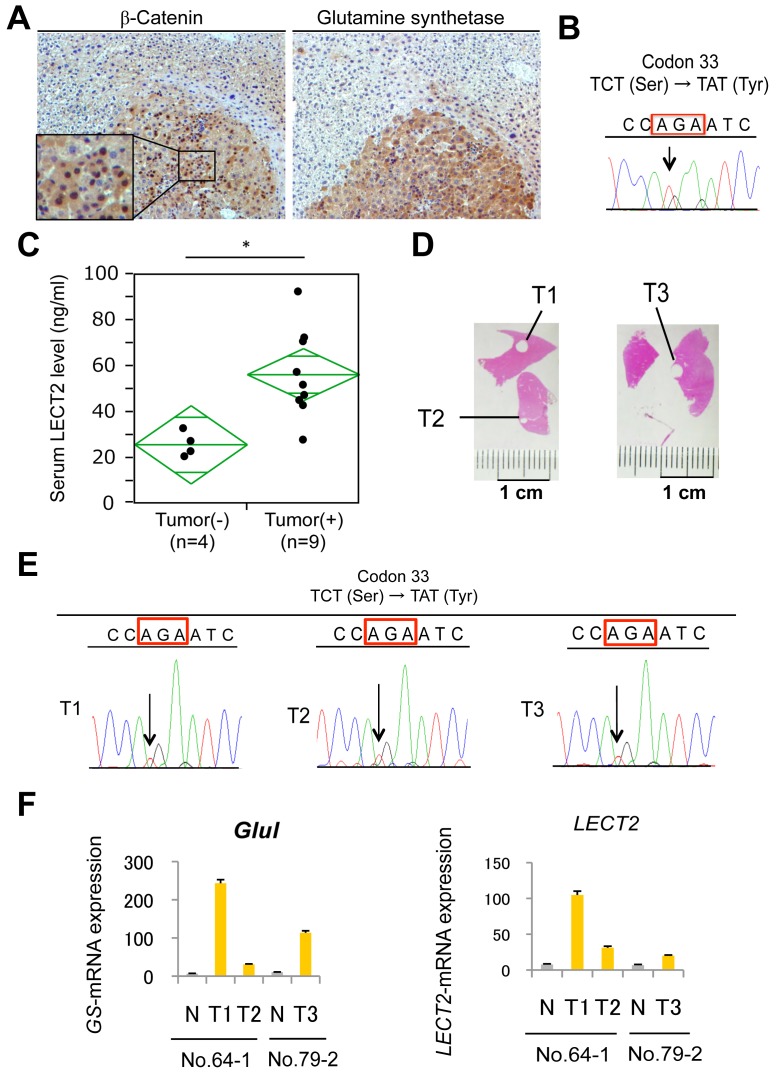
Serum LECT2 levels in mice with β-catenin gene mutated HCC.A. Representative picture of β-catenin (left panel) and GS (right panel) immunohistochemistry of liver of a tumor bearing mouse at 8 months after DEN/PB treatment. Magnification, 100×. B. Using frozen tissue from a representative tumor, β-catenin gene exon-3 mutation affecting codon 33 (red box) was confirmed by direct sequencing. C. Serum LECT2 levels were significantly (*) increased in tumor bearing versus non-tumor bearing DEN/PB treated mice as analyzed by ELISA. (* p<0.01). D. Representative pictures of frozen sections from which tumors (T1-T3) were scraped for direct sequencing. E. Sequence analysis from three tumor lesions (T1-T3) show S33Y-β-catenin gene mutations in codon 33 (red boxes) by direct sequencing. F. Glutamine Synthetase (Glul) and Lect2 expression in three tumor lesions (T1-T3) were assessed by qRT-PCR. Gene expression of background liver tissues surrounding tumor are shown as N.